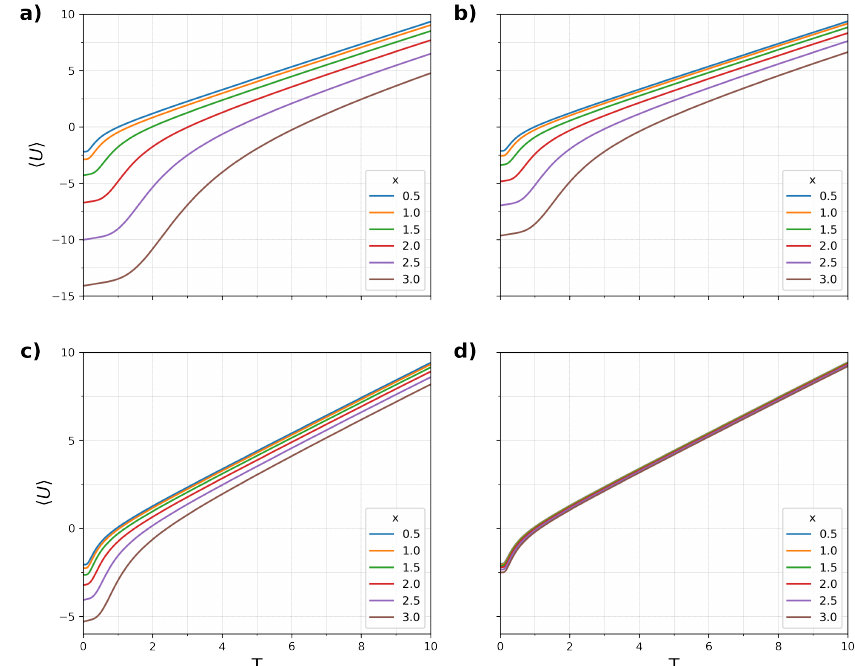
Figure 3. The results that we have obtained for the internal energy as a function of the temperature are presented in this figure. The curves correspond to different values of the dimensionless coupling constant x , from the up to the down curve x takes the values 0.5, 1, 1.5, 2, 2.5, 3 respectively. ( a – d ) stand for values of the asymmetry parameter α = 1, 1.5, 0.5, and 0.1,